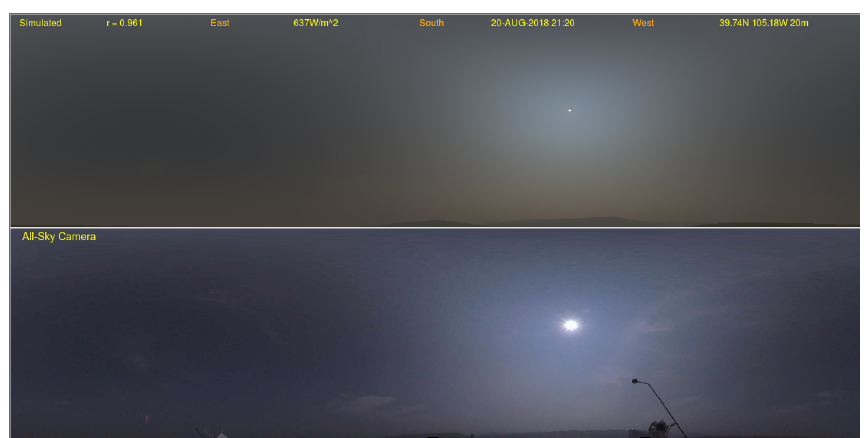
Figure 11. A comparison of aerosols at 21:00UTC on 20 August 2018 in Golden, Colorado, showing a panoramic simulated (top) and an all-sky camera image (bottom). The correlation r between the images is denoted as 0.961.